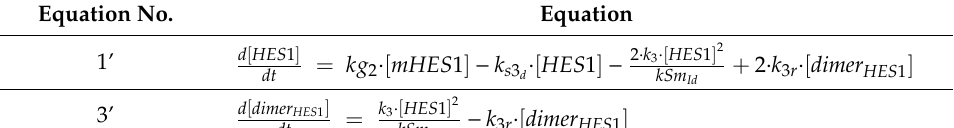
Table 3. Di ff erential equations of a model with an incorporated inhibition of HES1 dimerization by Id2. Equation No.